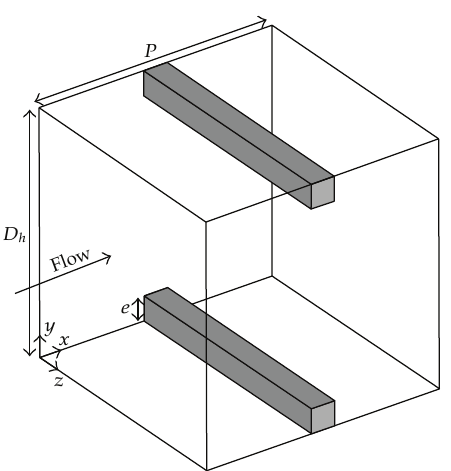
Figure 1: Three-dimensional computational domain (cid:2) aspect ratio (cid:8) 1 (cid:3)